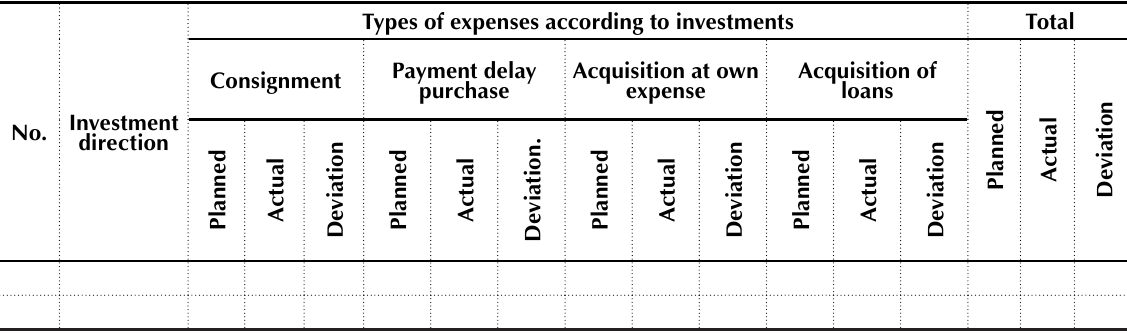
Table 2. Investment records form in the building up portfolio of proposals